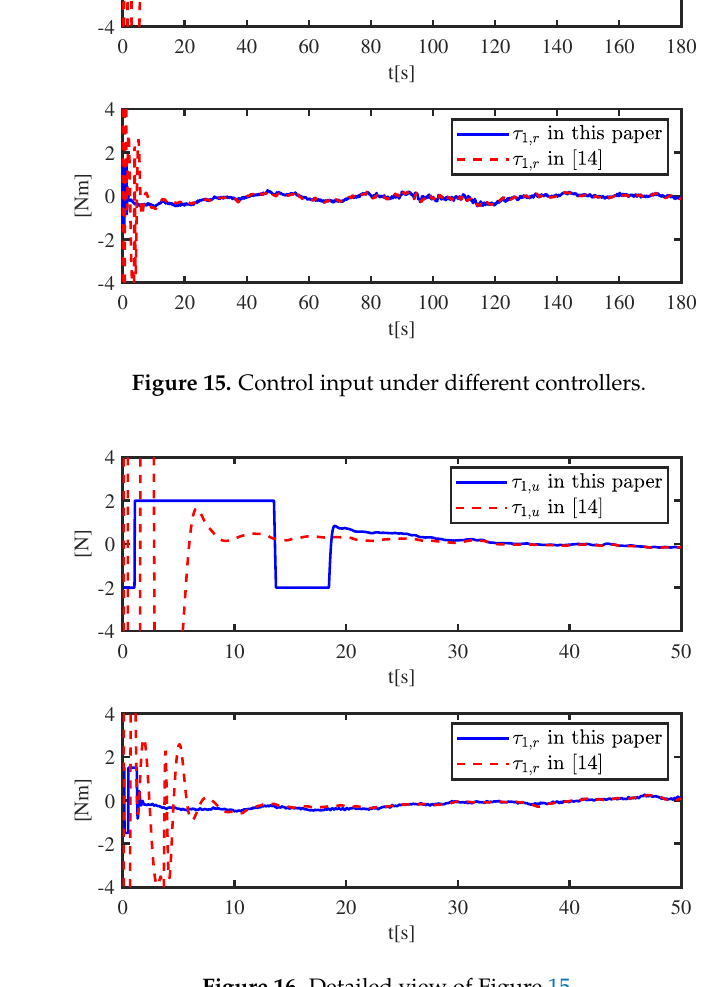
Figure 16. Detailed view of Figure